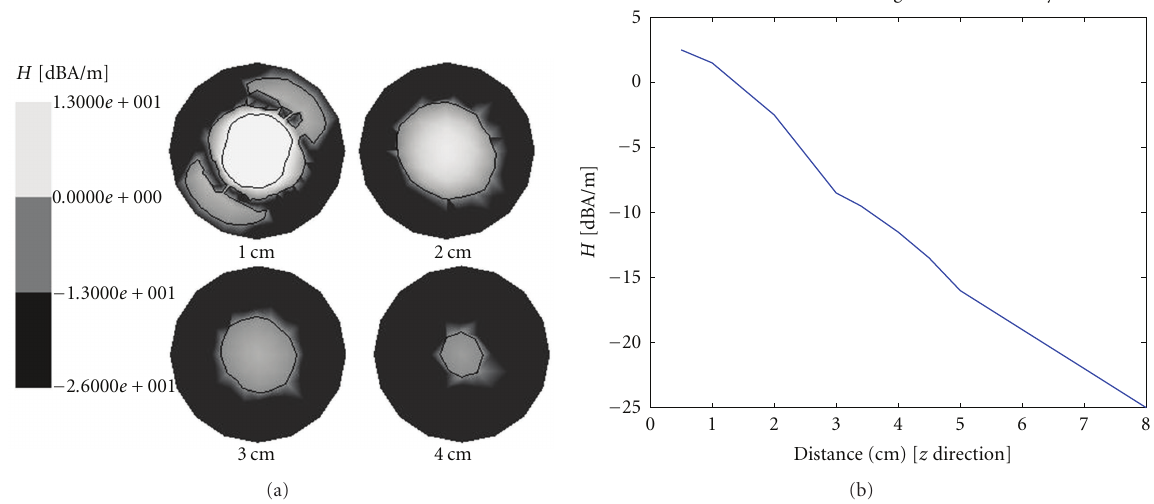
Figure 4: Simulated magnetic field distribution of the antenna operated at 868MHz: (a) z -orientationmagnetic field distribution at di ff erent z and (b) magnetic field intensity along z -axis.